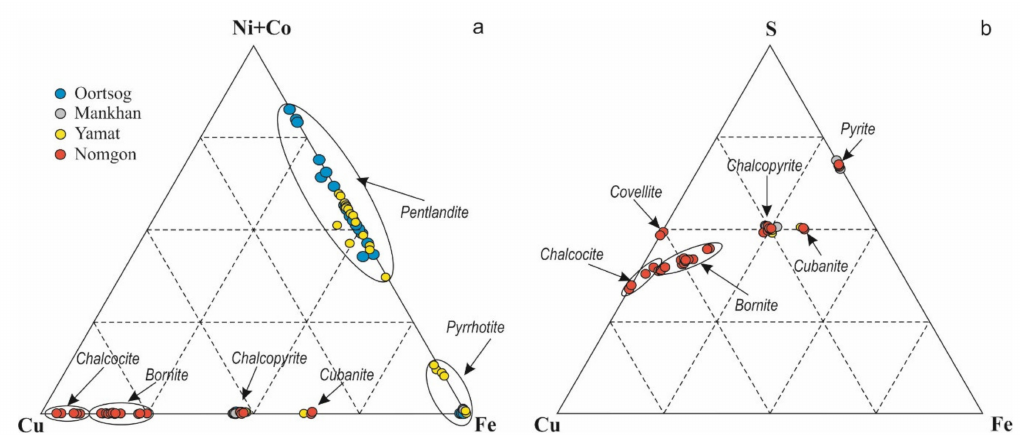
Figure 4. Variety of sulfides in mafic-ultramafic massifs of the Khangai upland: ( a ) Cu-Fe-Ni + Co; ( b )